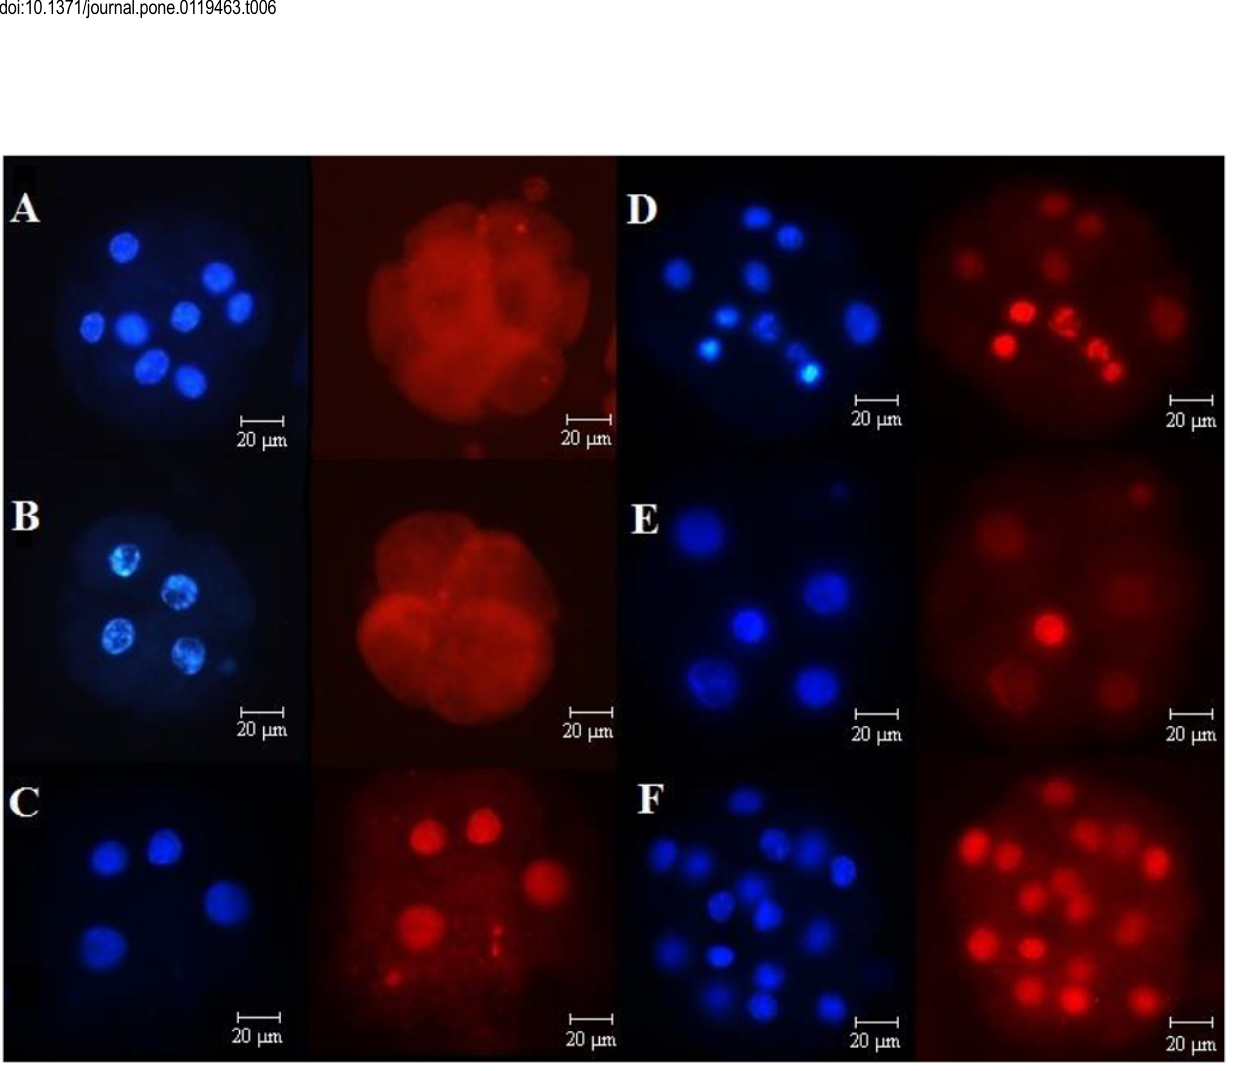
Fig 4. TUNEL assay. Epifluorescence photomicrography of embryos at 48 and 90 hpi classified according to the speed of development as either Fast (reached the fourth cell cycle at 48 hpi) or Slow/4 cells (exactly 4 cells and prior to the fourth cell cycle at 48 hpi). A) Fast embryo at 48 h of culture; B) Slow/4 cell embryo at 48 h of culture; C) embryo at 48 h of culture submitted to DNA fragmentation via exposure to DNase (technique positive control); D) Fast embryo at 90 h of culture; E) Slow/4 cell embryo at 90 h of culture; and F) embryo at 90 h of culture submitted to DNA fragmentation via exposure to DNase. The blue fluorescent nuclei indicate total cell number and red fluorescent staining indicates cells with fragmented